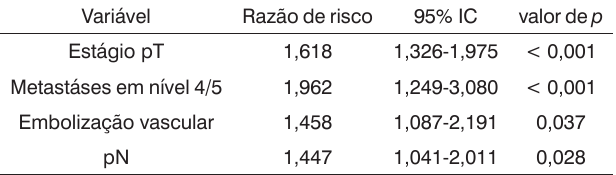
Tabela 6. Análise multivariada de sobrevivência doença -